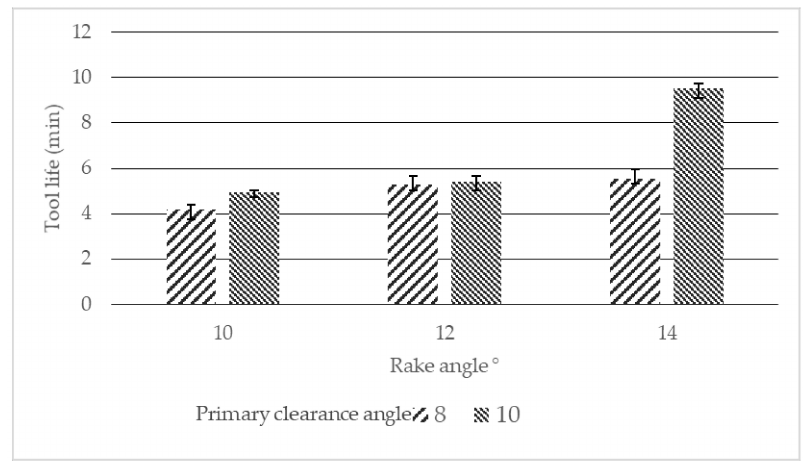
Figure 3. Tool life graph for various rake and primary clearance